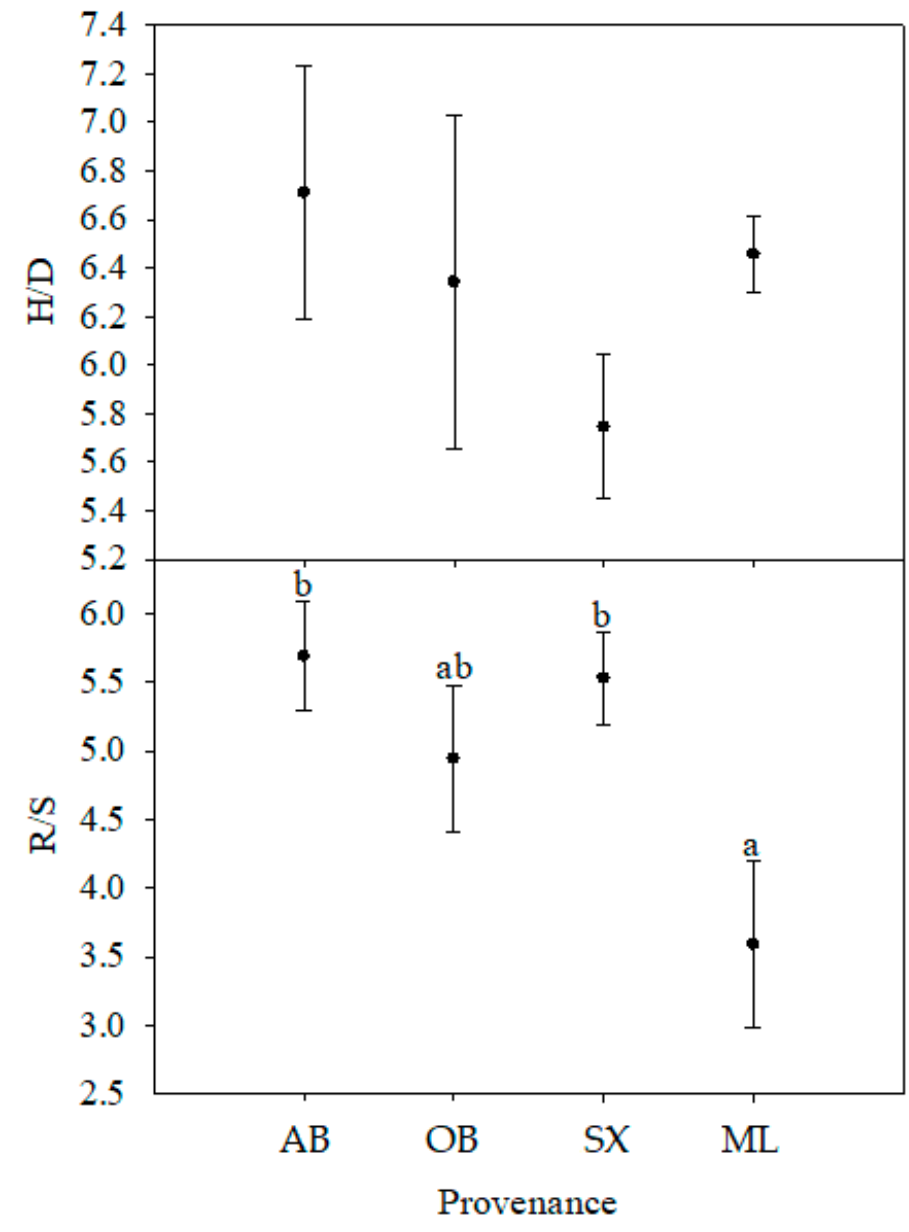
Figure 3. Effects of provenance on height–diameter ratio (H/D) and root–stem biomass ratio (R/S) in X. sorbifolium (mean ± SE). AB—Ar Horqin Banner; OB—Ongniud Banner; SX—Shanxian; ML— Mulei. Bars marked with different letters differ significantly according to Duncan’s test α = 0.05. The logistic growth curves of the seedlings from the four provenances are fitted in Figure 4 (diameter) and Figure 5 (height). All of the diameter growth curves indicated the ‘fast–slow’ trend, while height growth curves of OB and ML showed a ‘slightly slow–fast– slow’ trend in the four provenances. The estimated parameters are given in Tables 7 and 8. The average determination coefficient of the ground diameter (0.923) and height (0.986) indicated the feasibility of the fitting equations. Variance component analysis of the estimated parameters are given in Tables S5 and